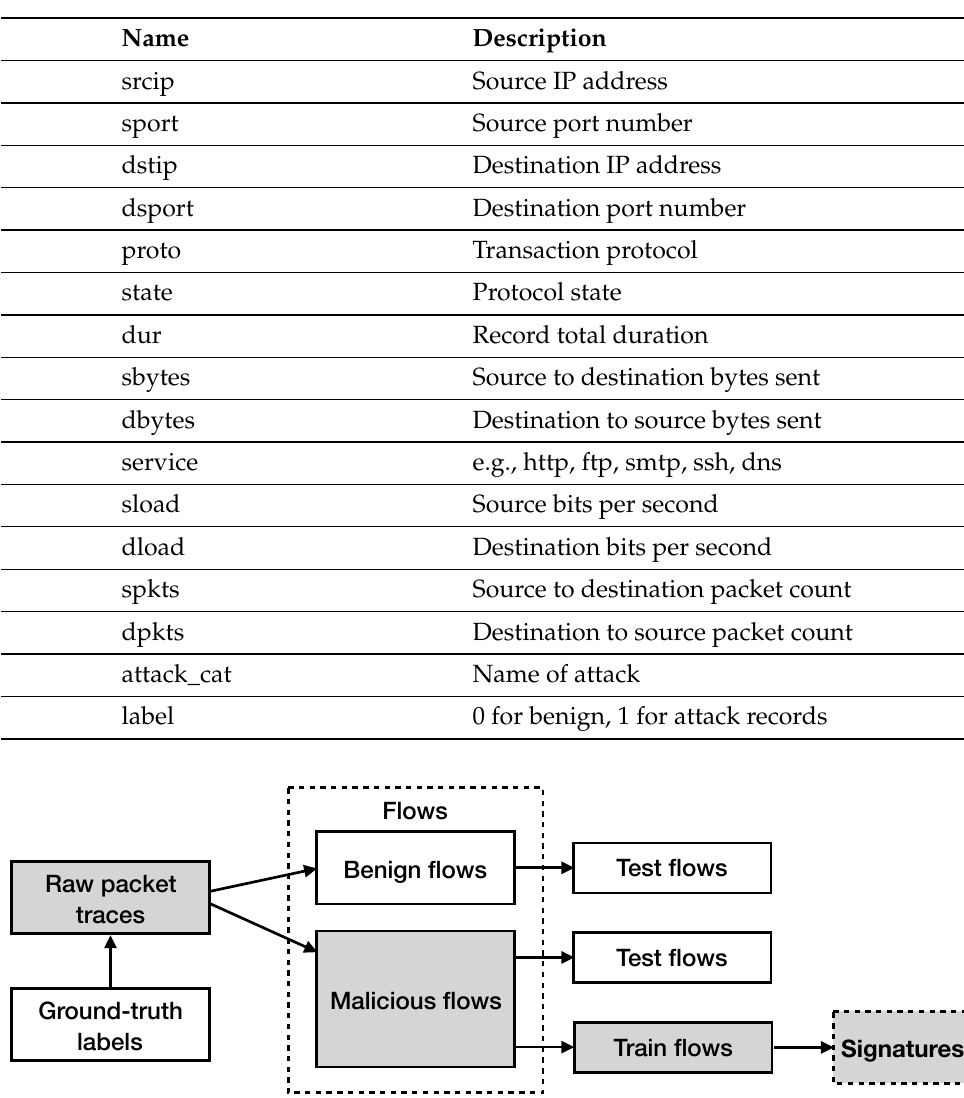
Table 3. A subset of the attributes and their descriptions that characterize a single attack record in the dataset [15].